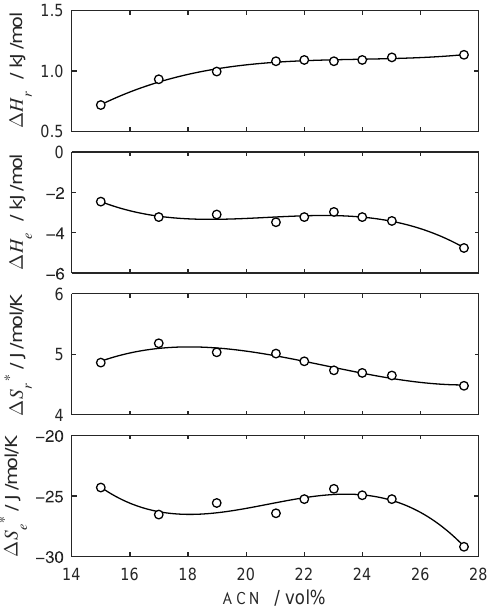
Figure 6. Thermodynamic parameters as function of the mobile phase composition. Symbols—parameters determined from measured retention times (see text). Lines—Interpolation by third-order